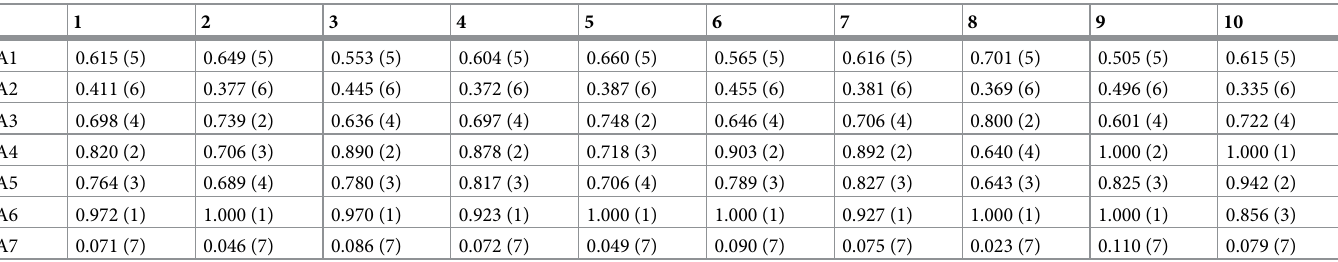
Table 11. Appraisal scores and final rankings of candidates for different decision expert weight distribution